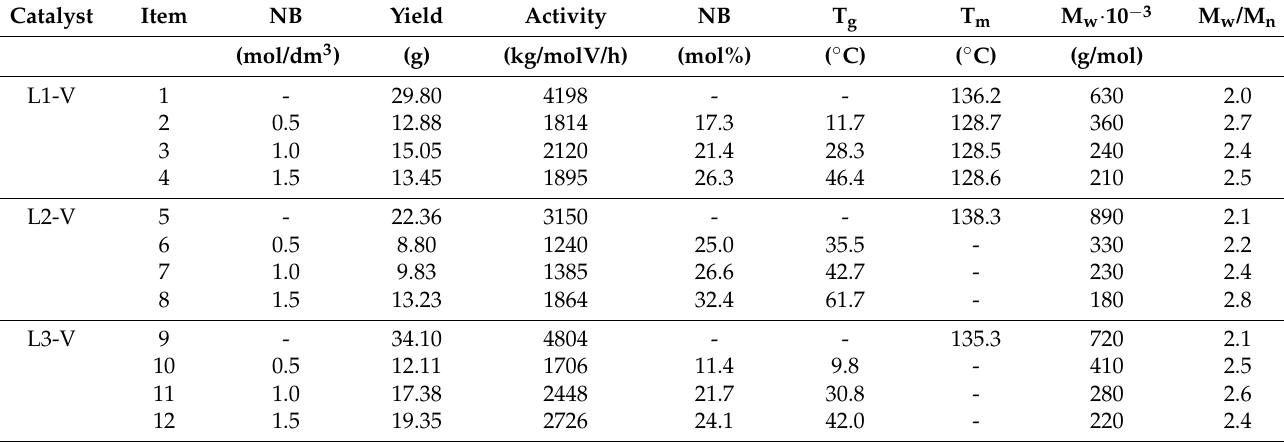
Table 1. Selected parameters of (co)polymerization performed using studied vanadium catalysts.